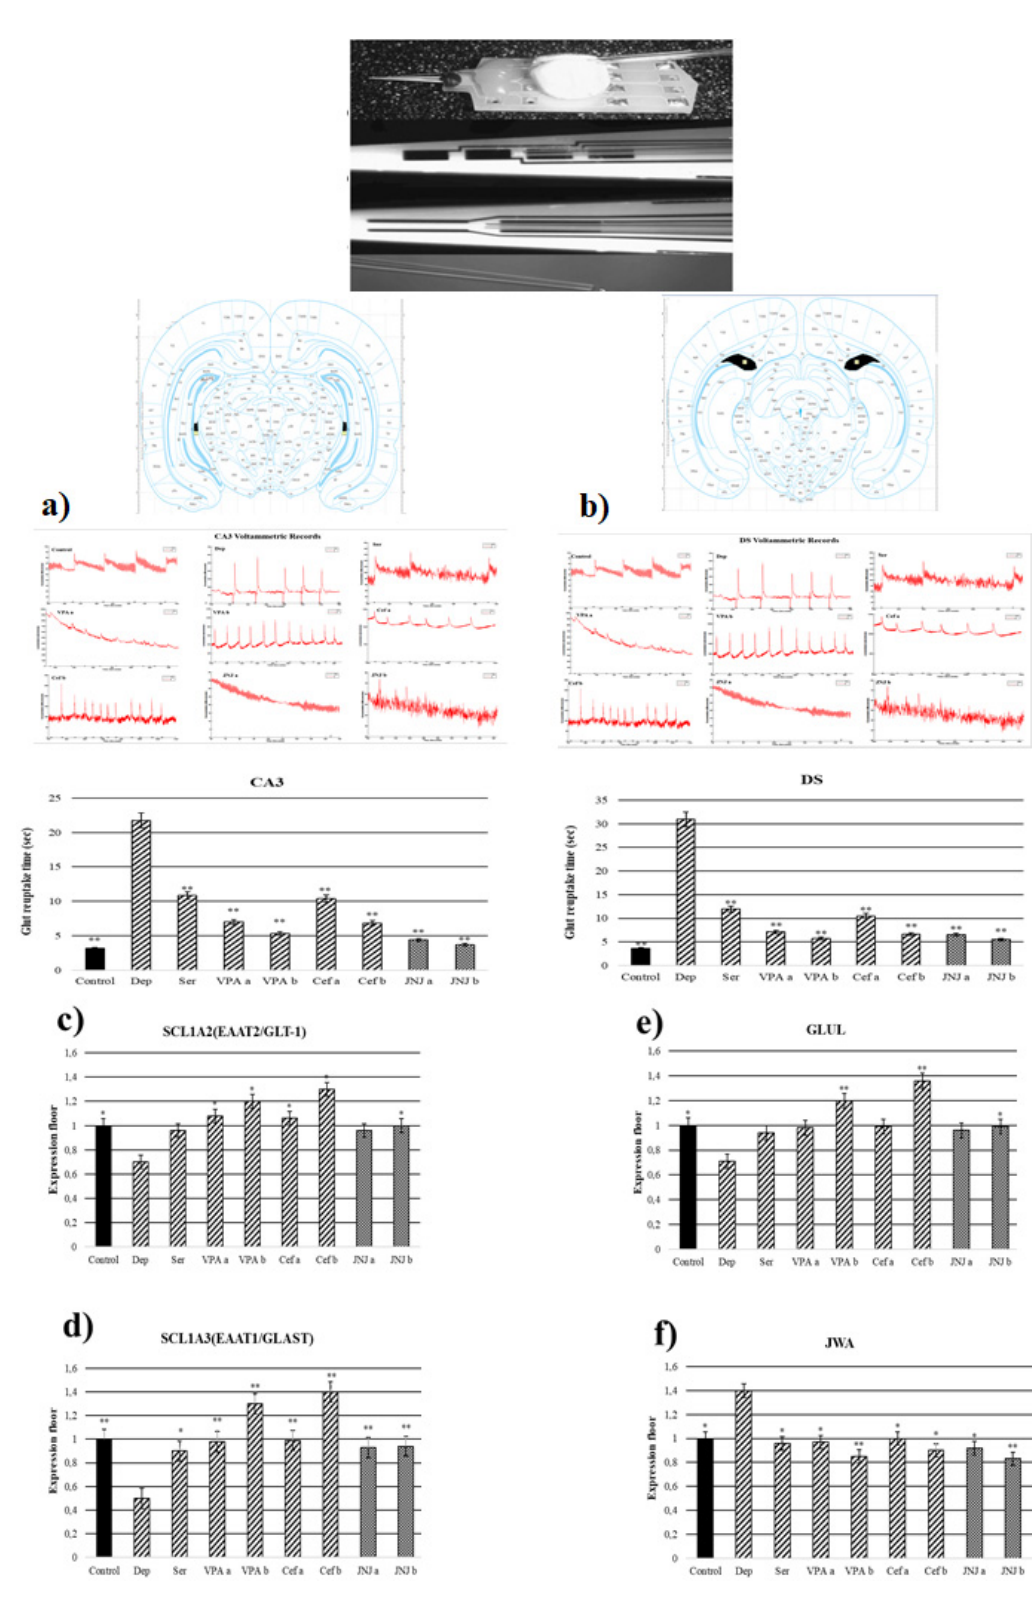
Figure 4. Glut reuptake times and gene expressions of experimental groups 30 days after treatment. ( a ) CA3 voltammetric records and glut reuptake time (s). ( b ) DS voltammetric records and glut reuptake time (s) ( c ) SLC1A2 gene expression. ( d ) GLUL gene expression ( e ) SLC1A3 gene expression. ( f ) JWA gene expression. One-way ANOVA, * p < 0.05, ** p < 0.001 compared with the Stress